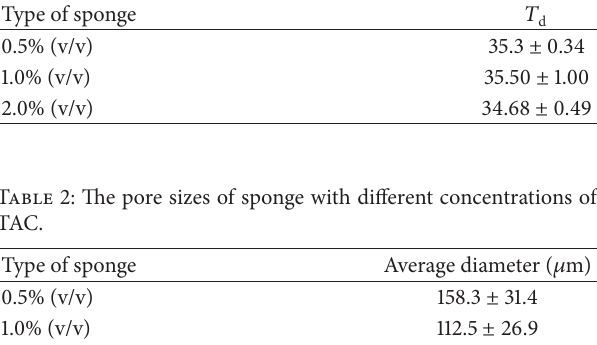
of sponge with different concentrations of TAC. Table 1: The 𝑇 d Type of sponge 𝑇 0.5% (v/v)